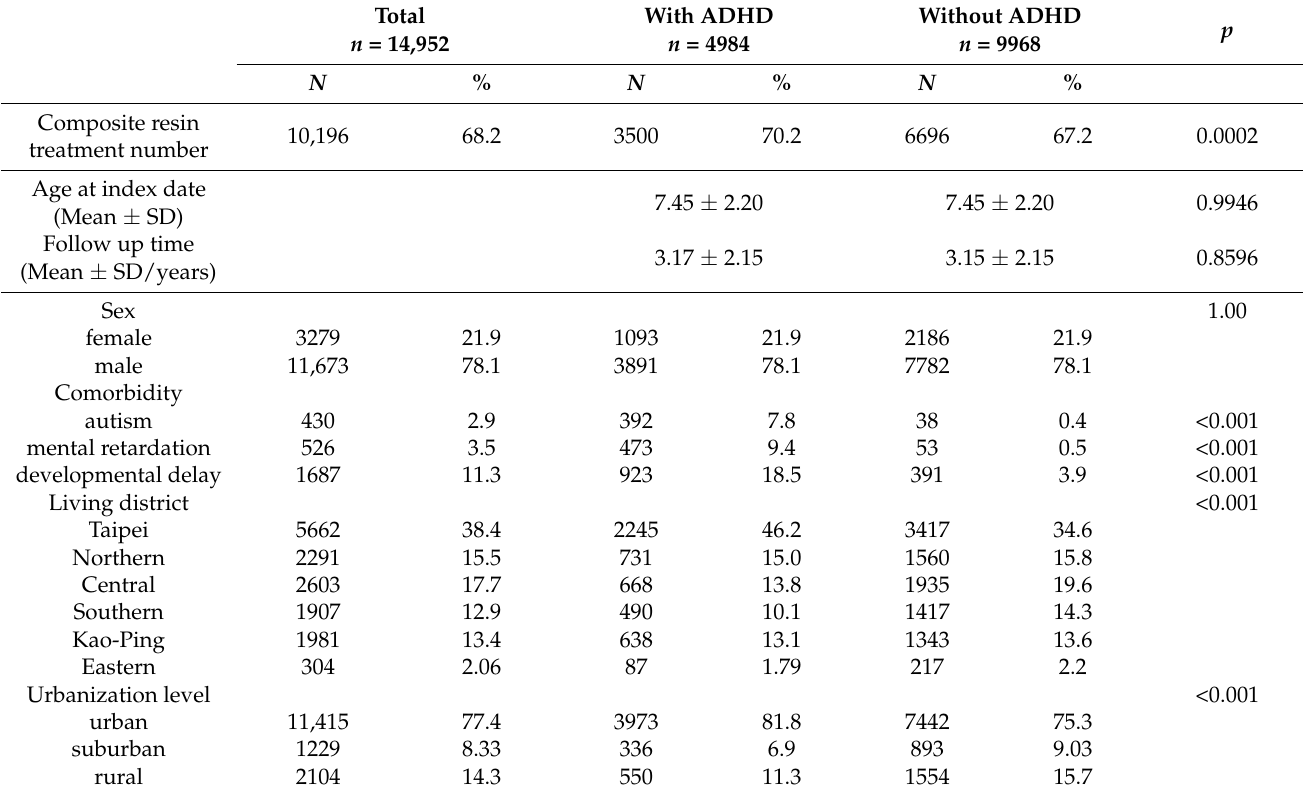
Table 1. Demographic characteristics and socioeconomic status of study subjects.